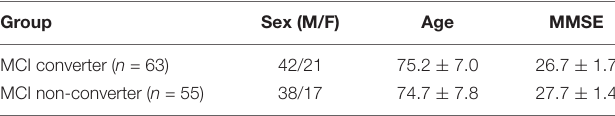
Values are mean ± standard deviation, where